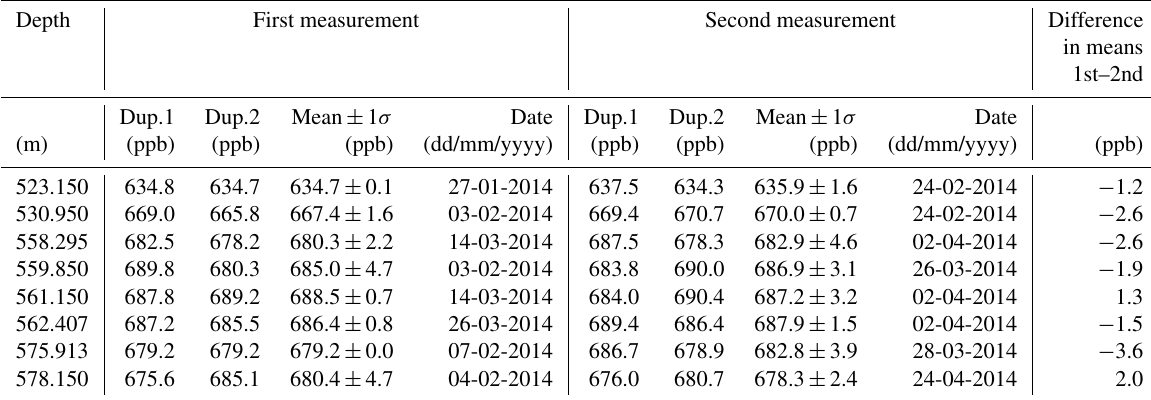
in means 1st–2nd